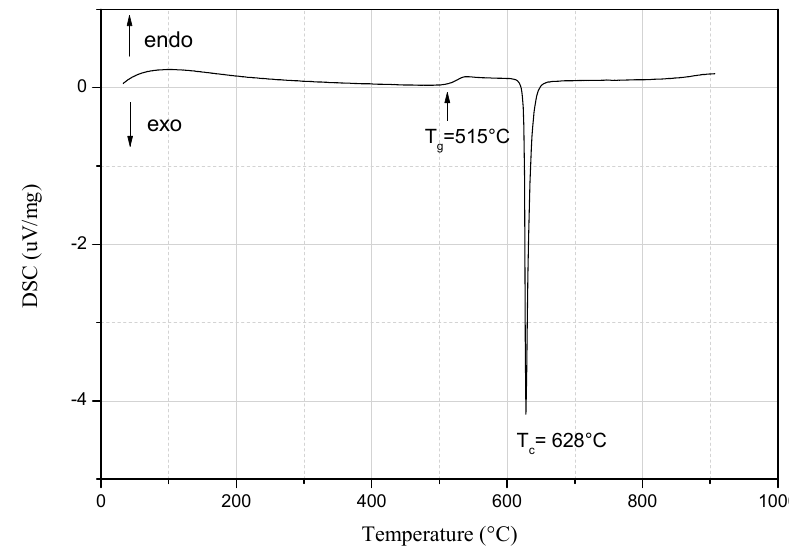
Figure 2. DSC of the prepared LAGP glass.